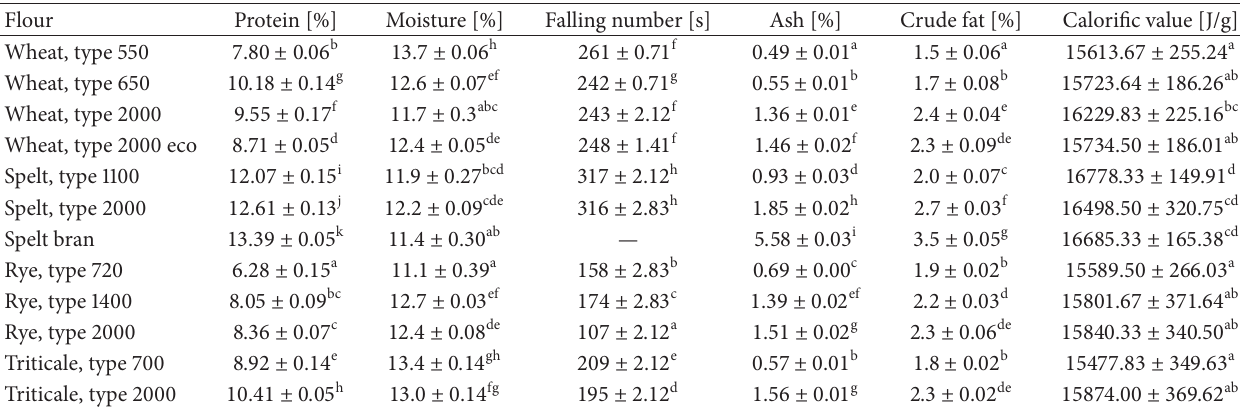
Table 2: Chemical composition of the analyzed flours.